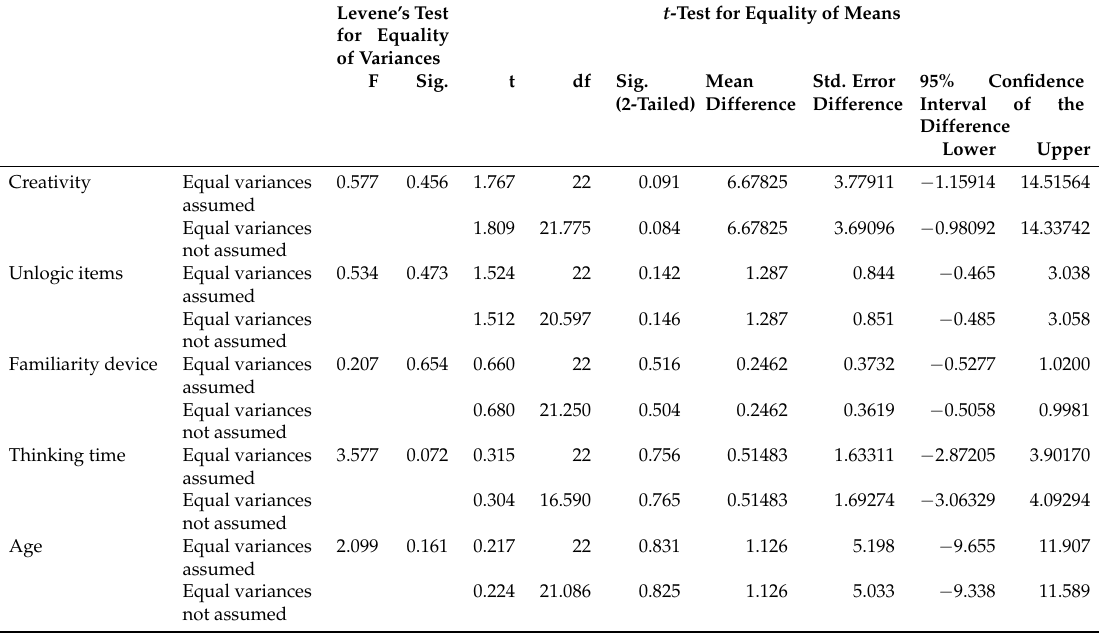
Table 3. Independent Samples